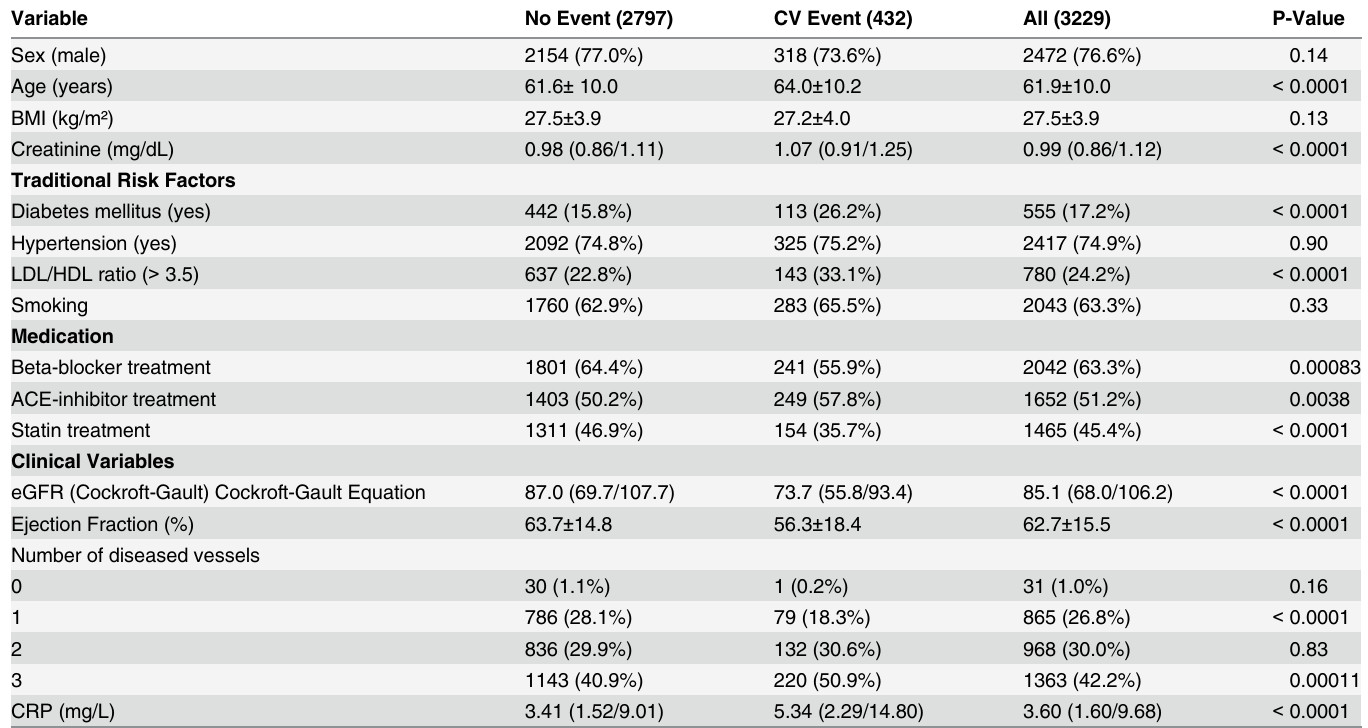
Table 1. Baseline Characteristics in the Athero Gene study N = 3229.